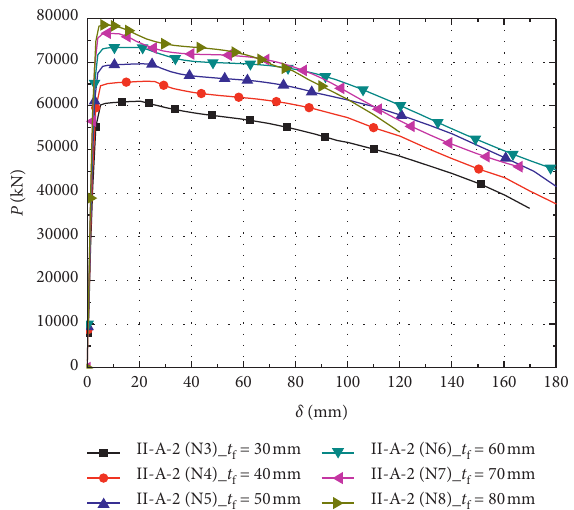
Figure 17: Effects of thickness of LYP steel tubular plate on skeleton curves.